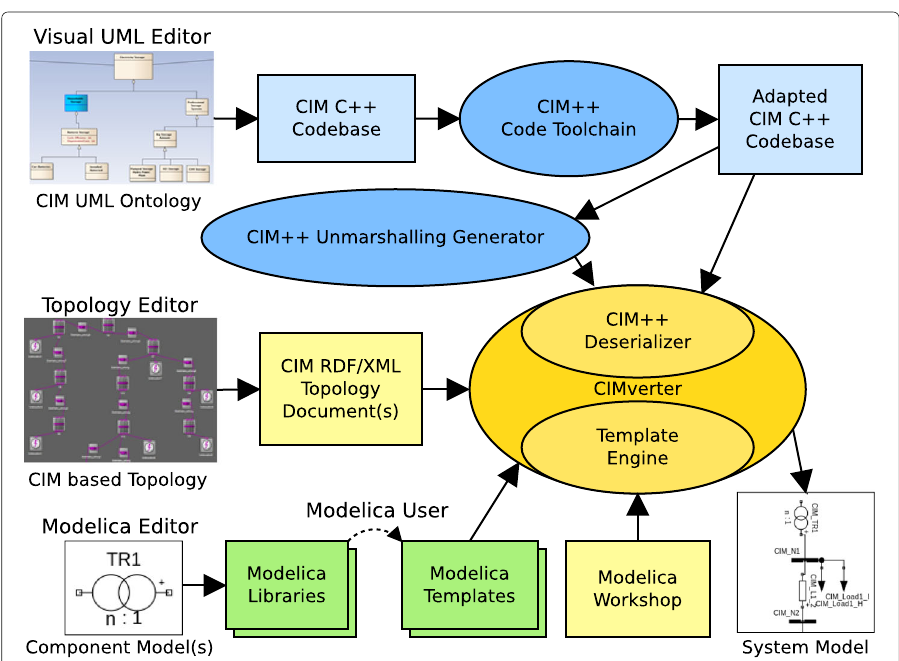
Fig. 3 Overall concept of the CIMverter project: The upper part shows the automated code generation process from the definition of the ontology by CIM UML to the unmarshalling code generation of the CIM++ Deserializer. The middle part shows the transformation process from a given topology (based on the specified CIM ontology) to a Modelica system model, based on Modelica libraries which are addressed by appropriate Modelica